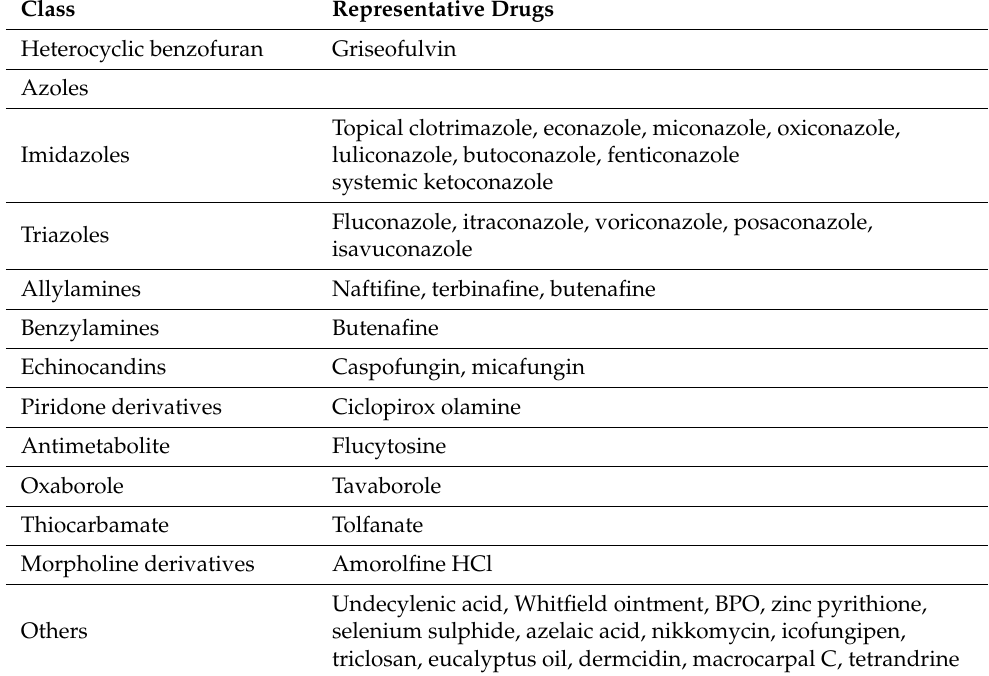
Table 1. Classification of systemic antifungals.